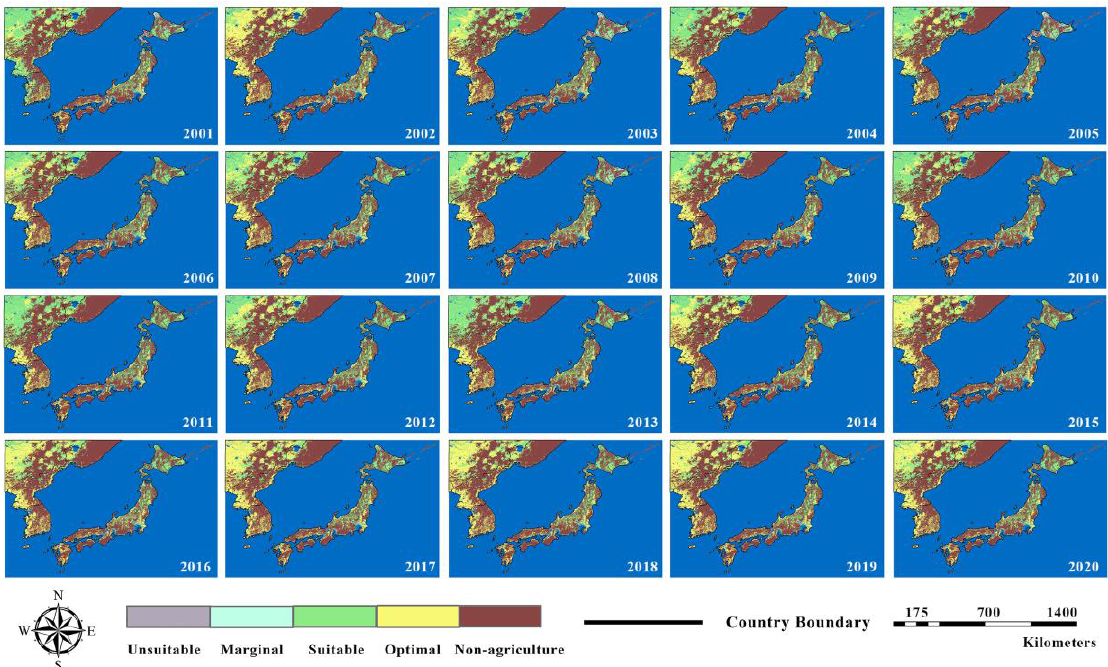
Figure 3. Bio-geophysical suitability maps of East Asia from 2001 to 2020 in spring.